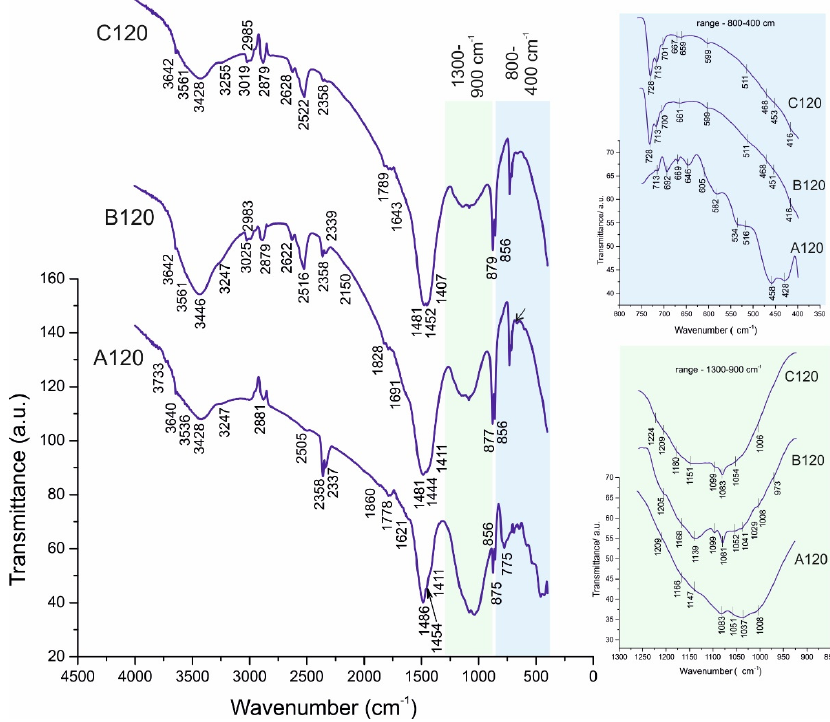
Figure 6. FTIR spectra of A120, B120, and C120. Magnifications: spectral ranges 1300–850 cm − 1 , and 800–350 cm − 1 . Table 5. Results from FTIR spectroscopy of raw materials (white Portland cement and marble powder) and A028, A120, B028, B120, C028, and C120. Description/